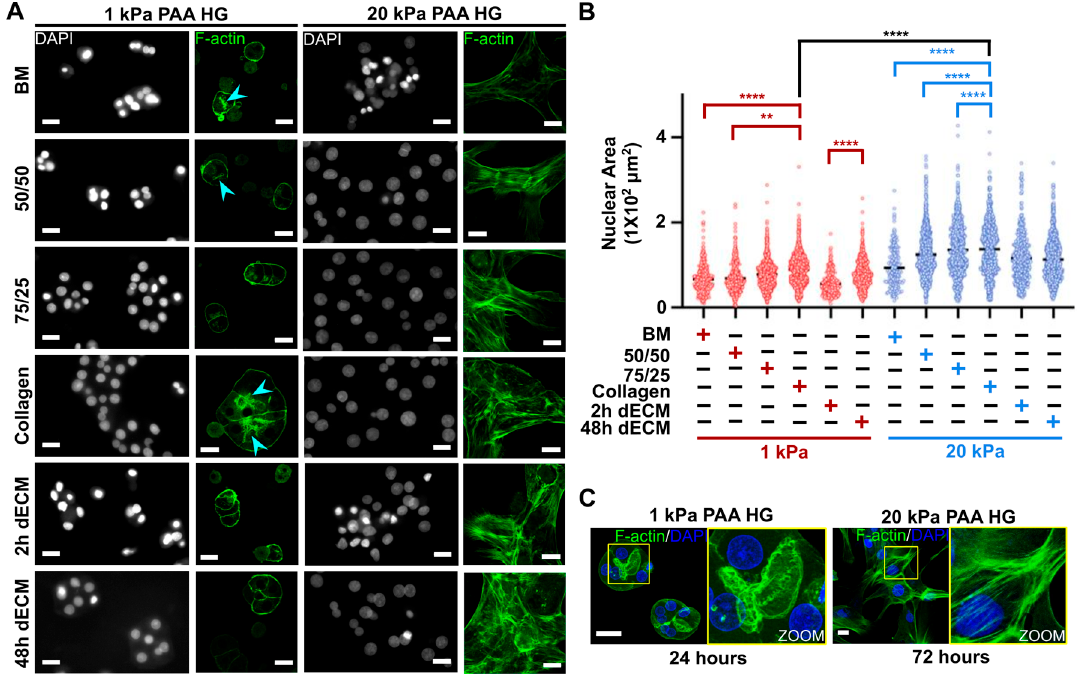
Figure 2. Actin cytoskeleton remodeling and nuclear area increase are inhibited in primary hepatocytes cultured on soft PAA HGs. ( A ) Representative fluorescence images of nuclei (4 ′ ,6-diamidino-2-phenylindole, or DAPI) and actin filaments (F-actin) in hepatocytes after 72 h of culture on soft and stiff PAA HGs conjugated with ECM matrices. Actin filaments proximal to canaliculi-like structures: light blue arrowhead. Images were obtained from 40× (epifluorescence) and 63× (confocal microscopy) objectives for nuclei and F-actin, respectively. Scale: 20 μ m. ( B ) Quantitative analysis of nuclear area in primary hepatocytes cultured on soft and stiff PAA HGs linked to different ECM. ECM mixtures: BM, 100% Matrigel; 50/50, 50% collagen type I plus 50% BM; 75/25, 75% collagen type I plus 25% BM; collagen, 100% collagen type I; 2 h dECM, dECM after 2 h of digestion; 48 h dECM: ECM after 48 h of digestion. Significant differences are shown in red and blue between PAA HG with the same elastic condition; black lines show significant differences between PAA HGs with the different elastic conditions. Data are represented as mean ± SD of a representative of two independent experiments, ** p < 0.01, **** p < 0.0001. ( C ) 3D projections of confocal images of hepatocytes cultured on 1 kPa and 20 kPa PAA HGs at 24 h and 72 h after culture, respectively. Canaliculi-like structures and stress fibers are highlighted and magnified at yellow squares (right panels). Scale bars: 20 μ m.